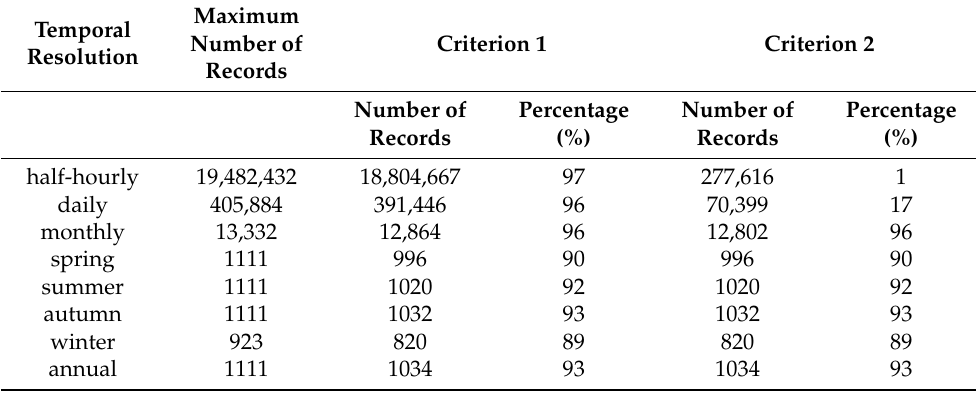
Table A1. Data availability for each temporal resolution considered in the study.